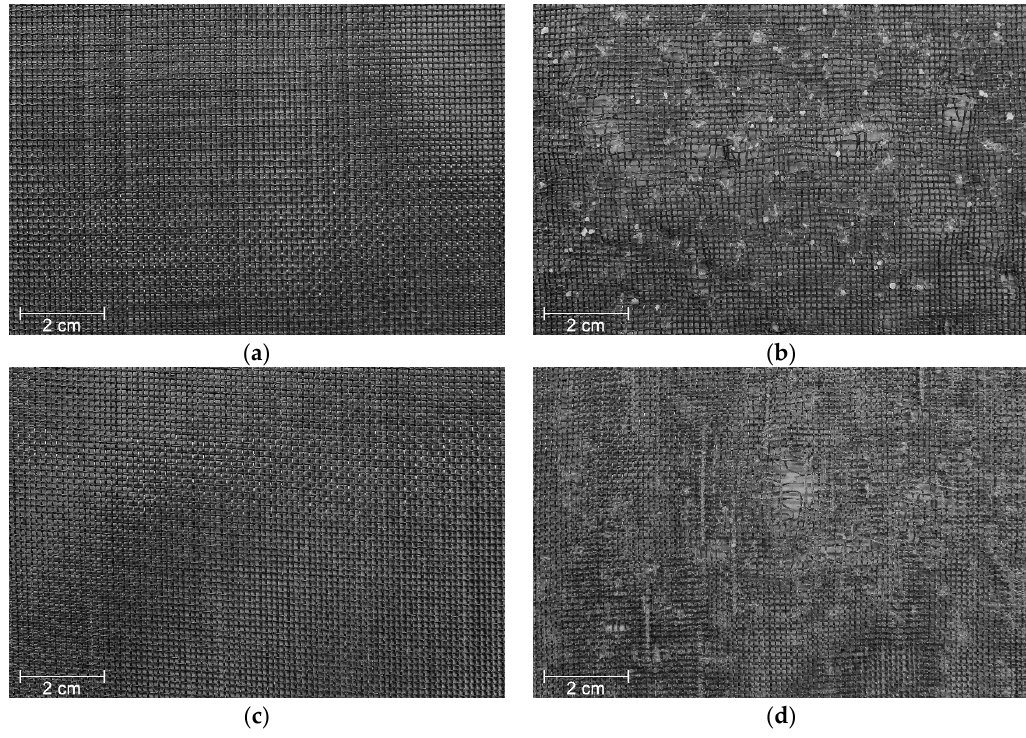
Figure 3. Visual inspection of geotextile W180: ( a ) undamaged sample; ( b ) after mechanical damage under repeated loading; ( c ) after abrasion; ( d ) after successive exposure to mechanical damage under repeated loading and abrasion.